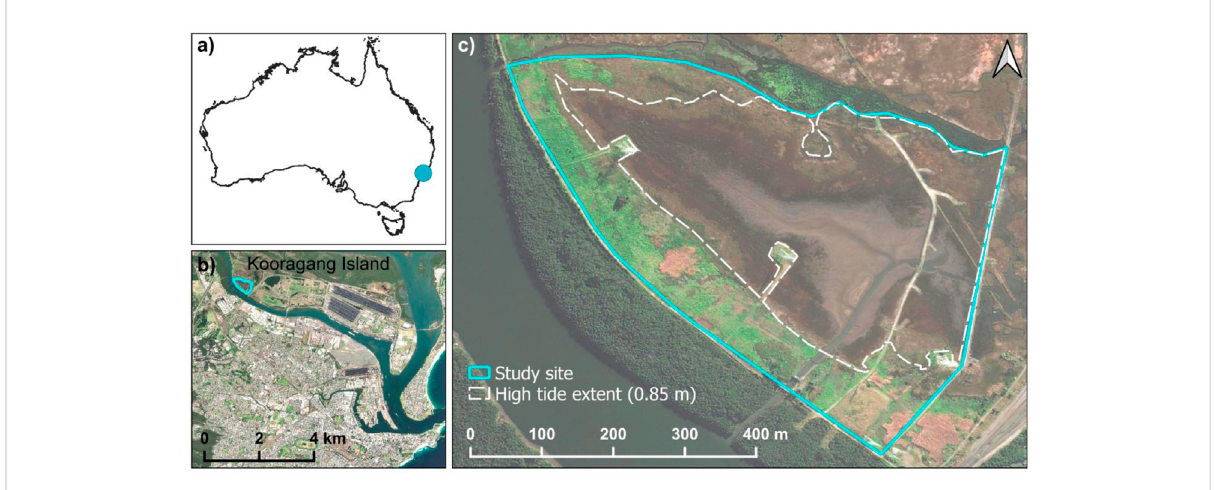
FIGURE 1 Study site extent with respect to: (A) Australia, (B) Kooragang Island and (C) Fish Fry Flat, also showing high tide extent. Imagery source: ESRI.